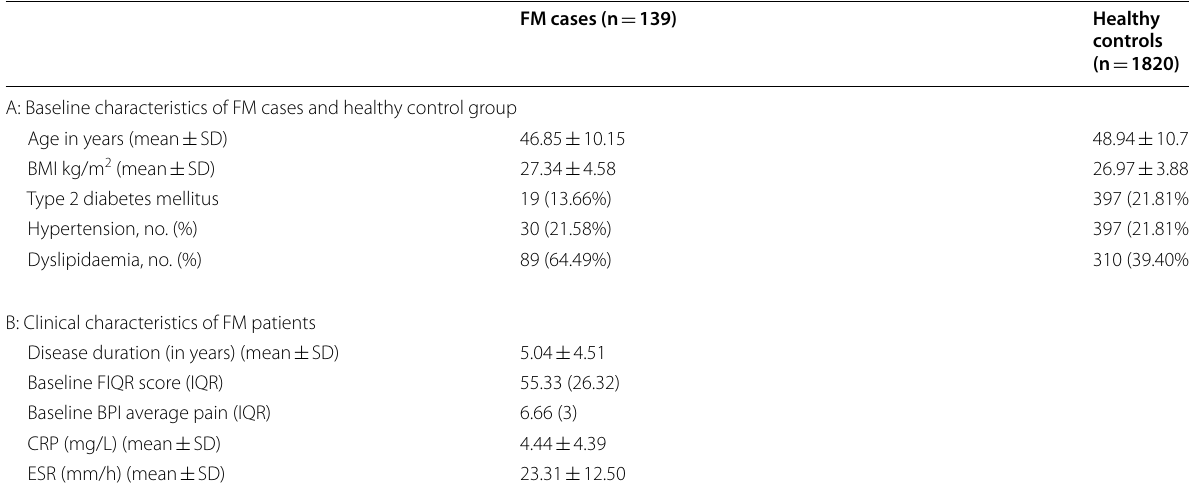
Table 1 Baseline characteristics of study participants